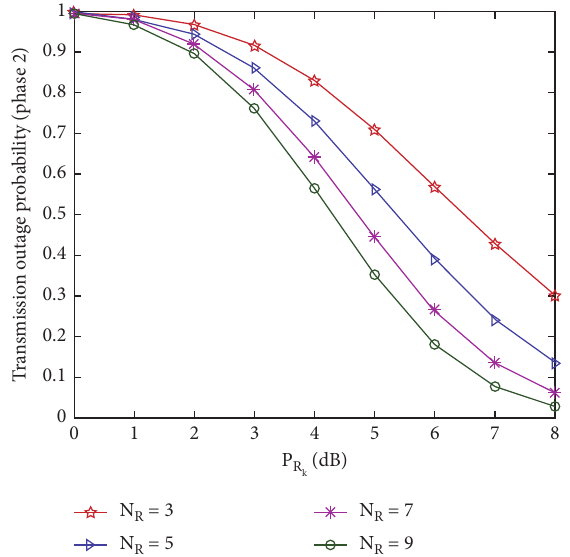
Figure 13: Transmission outage probability versus P ferent value of N R , where R � 1 . 5 and σ 2 B � 0 dB .